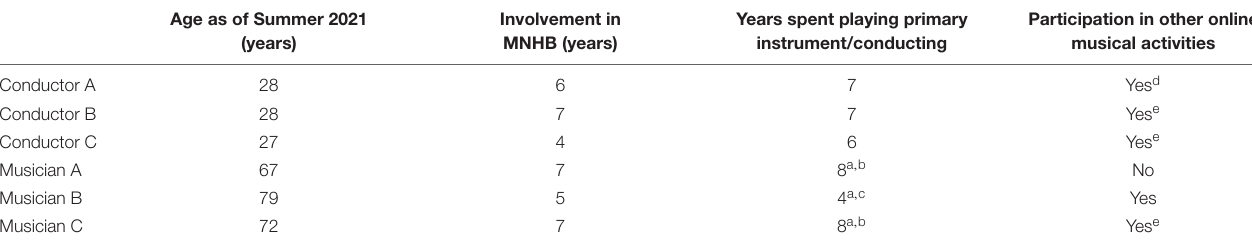
TABLE 2 | Demographic information of study